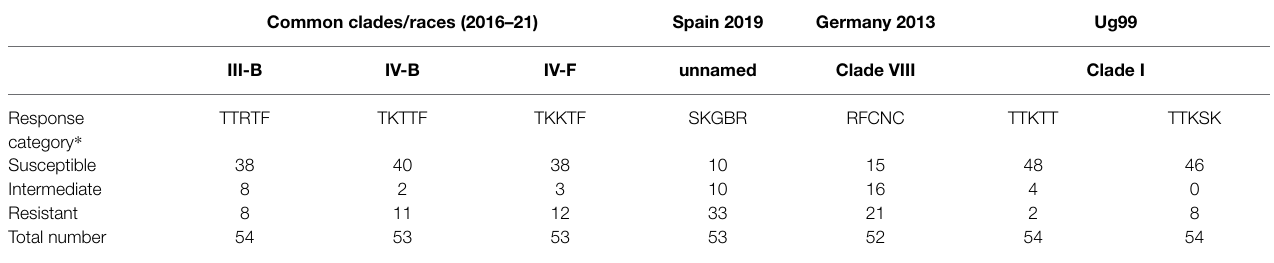
TABLE 8 | Seedling response of European wheat varieties to three clades representing prevalent races of P. graminis f.sp. tritici in Europe, a race from a recombining population in Spain, a race from the German outbreak 2013, and two races representing Ug99 from East